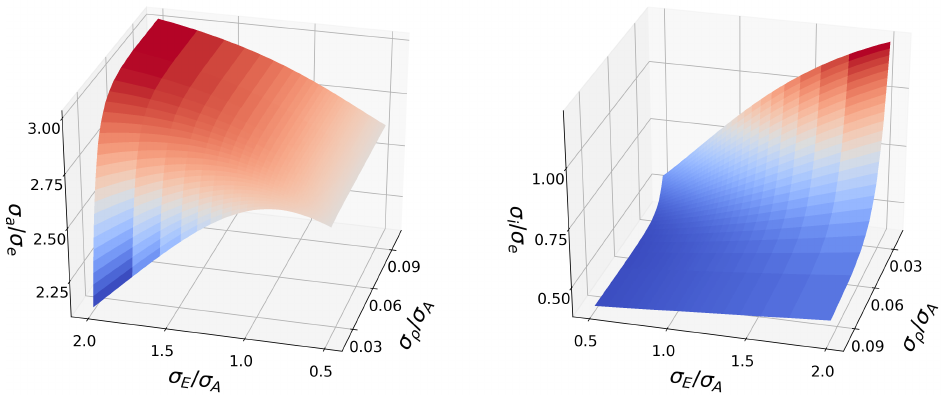
Figure 2. Effect of weight on the accuracy of estimated orbital